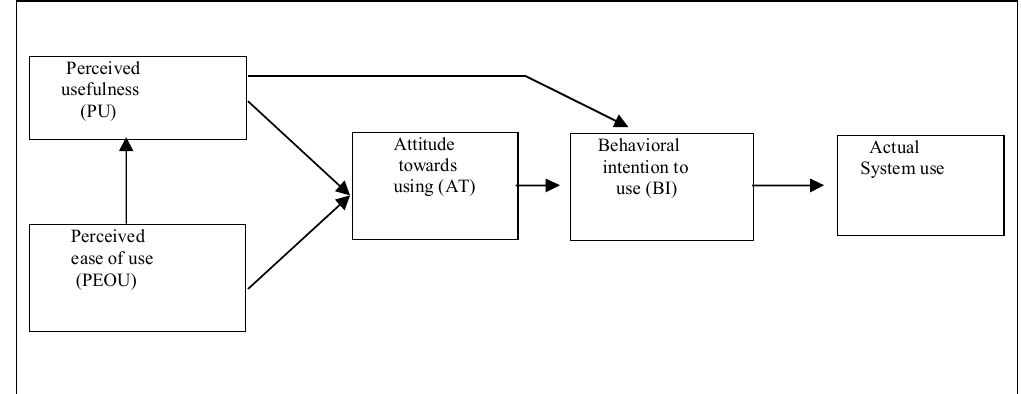
Fig. 1. TAM model (Davis et al.,